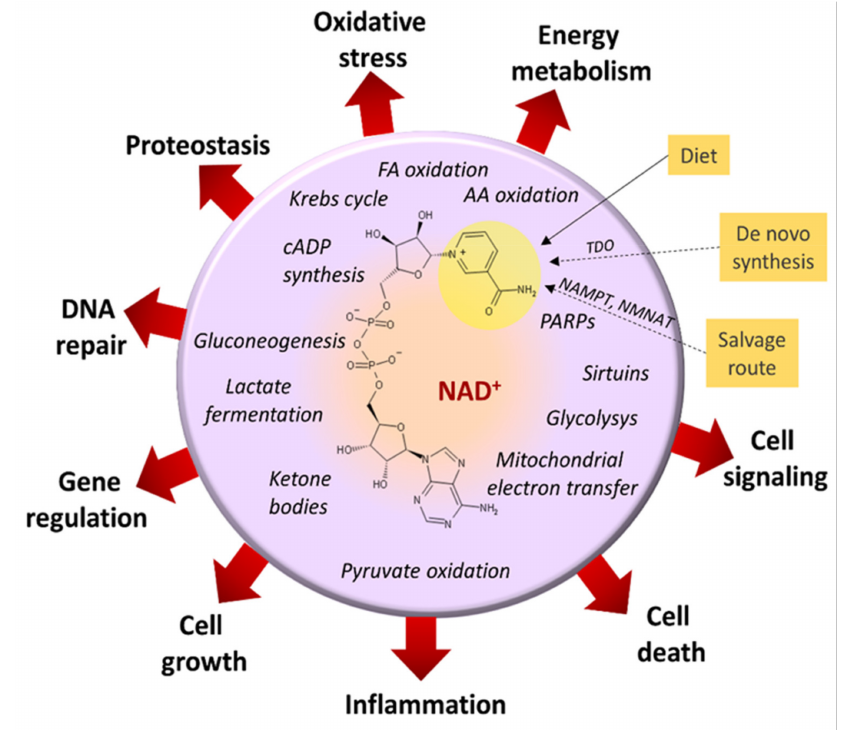
Figure 3. Representation of the metabolic routes affected by an imbalance in the ratio of free coen- zymes NAD+/NADH. This imbalance provokes alterations in cell function related to depleted energy state, alteration of DNA repair mechanisms, and the derangement of cell signaling and cell growth with consequent cell death or cell transformation. Dotted arrows indicate several reactions in a metabolic pathway. AA, amino acid; FA, fatty acid; NAMPT, nicotinamide phosphoribosyltrans- ferase, EC 2.4.2.12; NMNAT, nicotinamide mononucleotide adenylyltransferase, EC 2.7,7.1; PARPs, poly(ADP)-ribo. 4.2.30; TDO, tryptophan 2,3-dioxygenase, EC 1.13.11.11